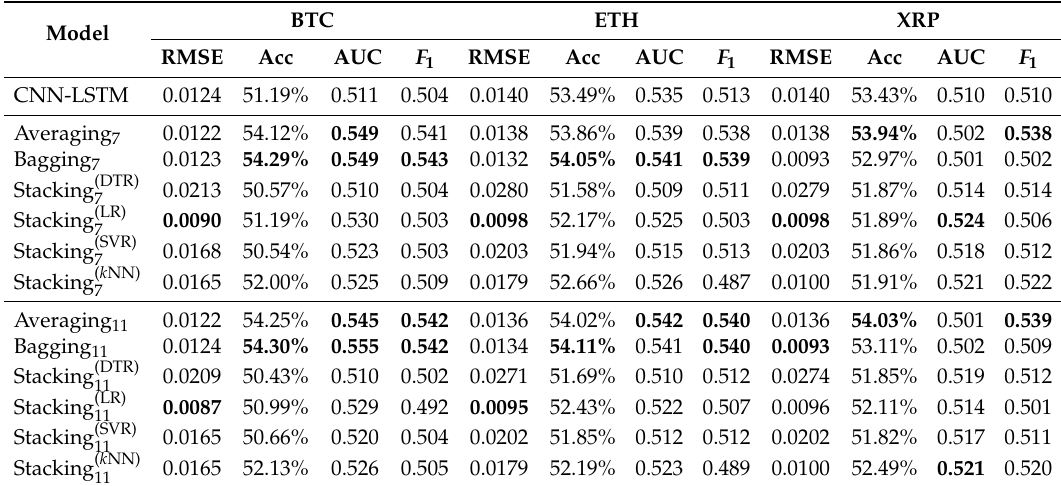
Table 4. Performance of ensemble models using CNN-LSTM as base learner for m = 9.